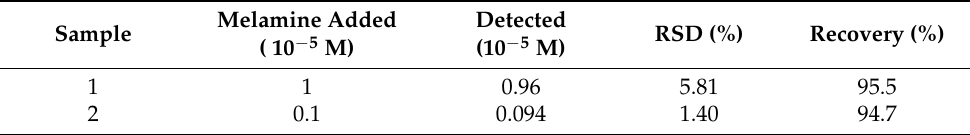
Table 2. Determination of melamine in real milk samples spiked with different concentrations of